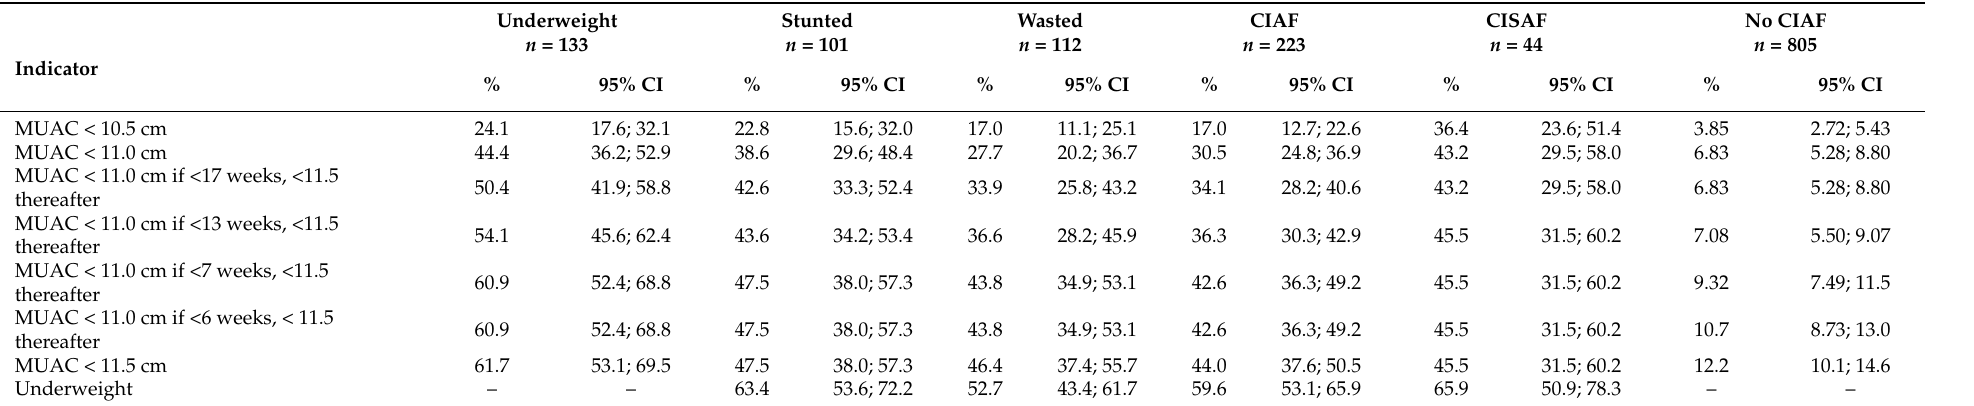
Table 4. Overlap of different anthropometric deficits with different low MUAC thresholds and